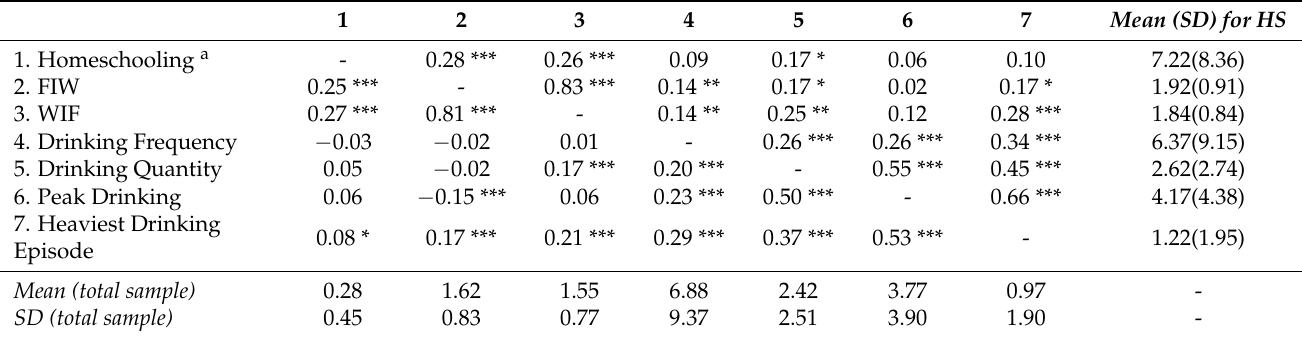
Table 2. Descriptive Statistics and Bivariate Correlations among Study